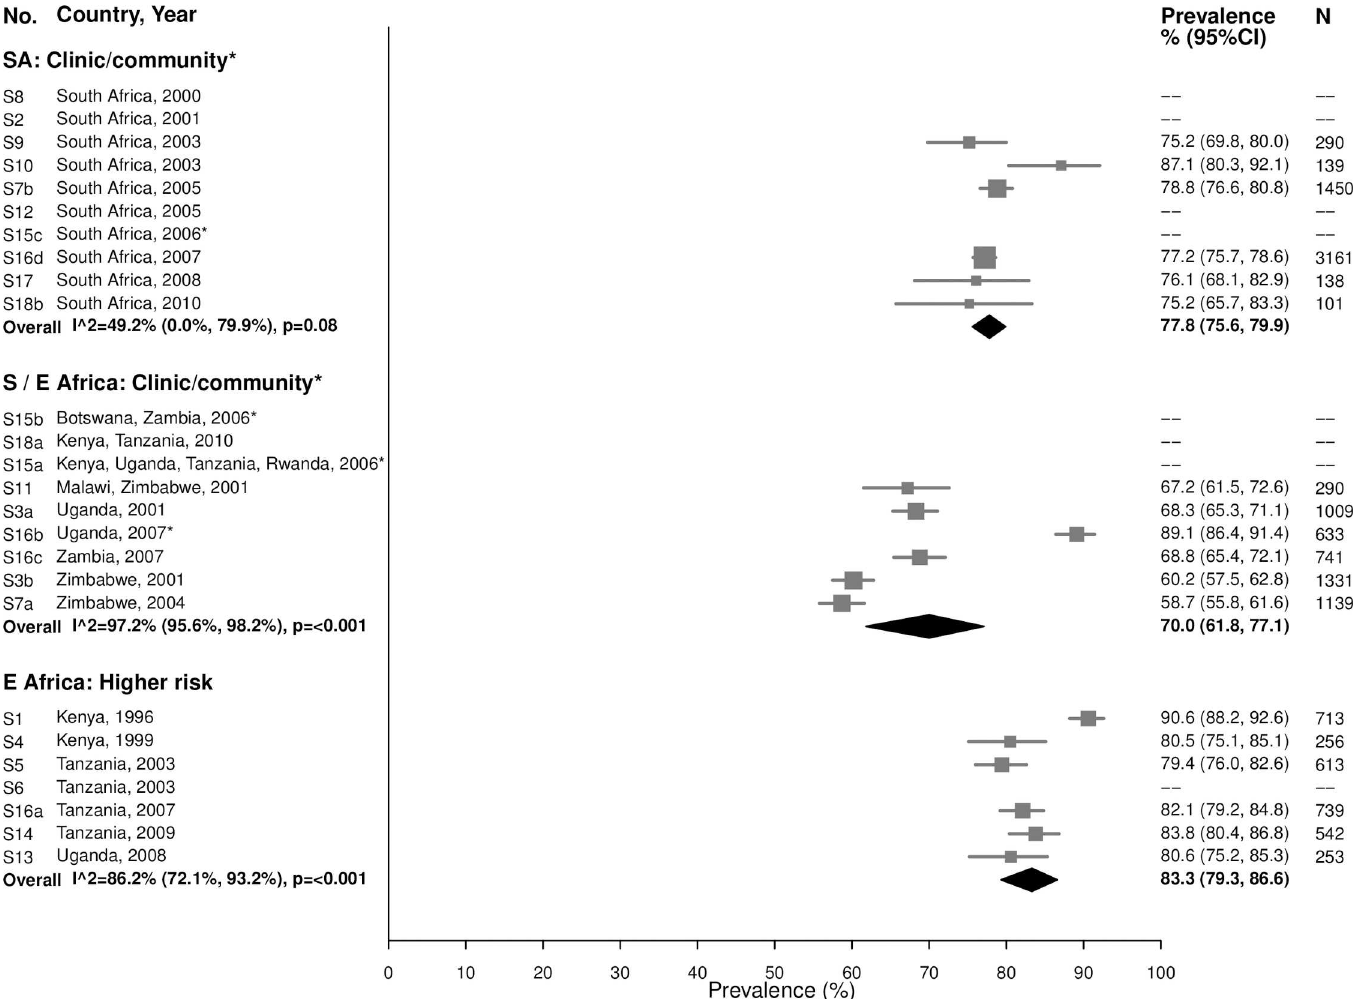
Fig 12. Herpes simplex virus type 2 prevalence among 25–49-year-olds. The area of the marker is proportional to the square root of the sample size. Studies with no estimate presented did not meet the inclusion criteria for this infection and age group. Year presented is the median year that baseline data were collected during the study. (cid:3) Includes studies of HIV-discordant couples. E Africa, Eastern Africa; SA, South Africa; S/E Africa, Southern and Eastern Africa.